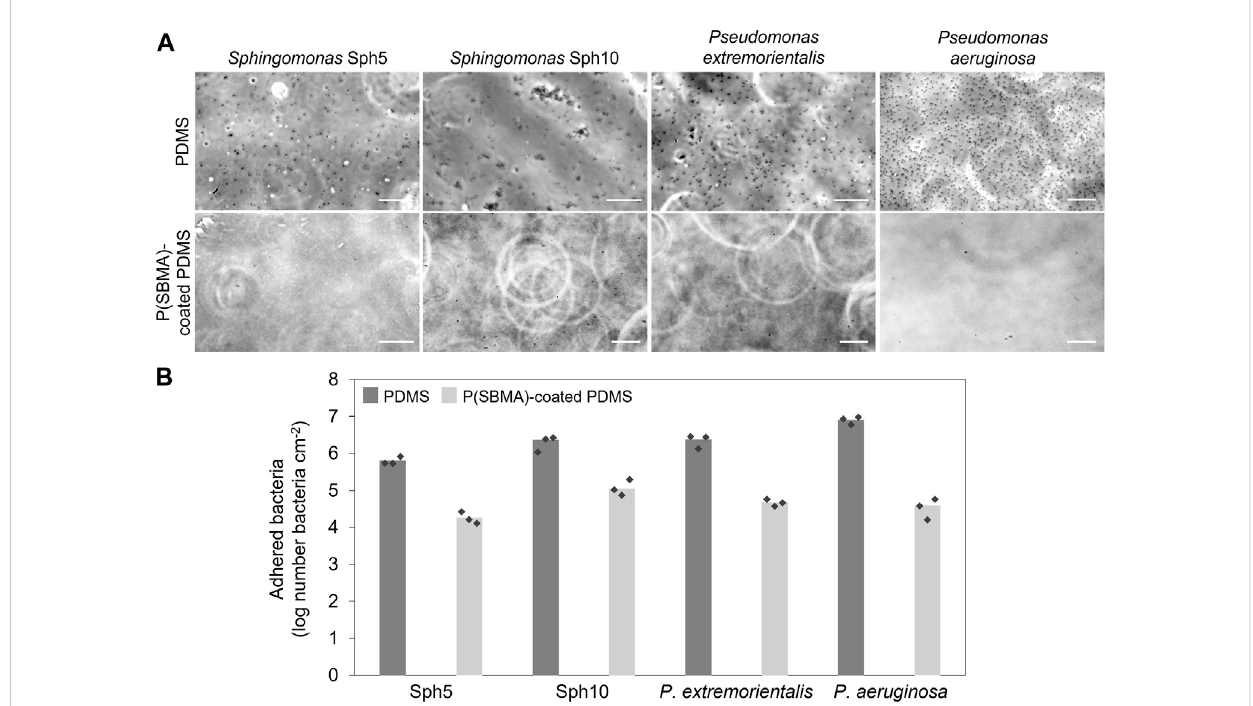
FIGURE 5 (A) Micrographs of four tested bacterial strains after 4 h adhesion tests on PDMS (top row) and P(SBMA)-coated PDMS (bottom row) surface. Scale bars are 20 µm. (B) Number of attached bacteria after 4 h adhesion on non-coated and P(SBMA)-coated PDMS. The values are averages of experiments performed on three separately coated surfaces with separately prepared bacterial cultures, indicated by the